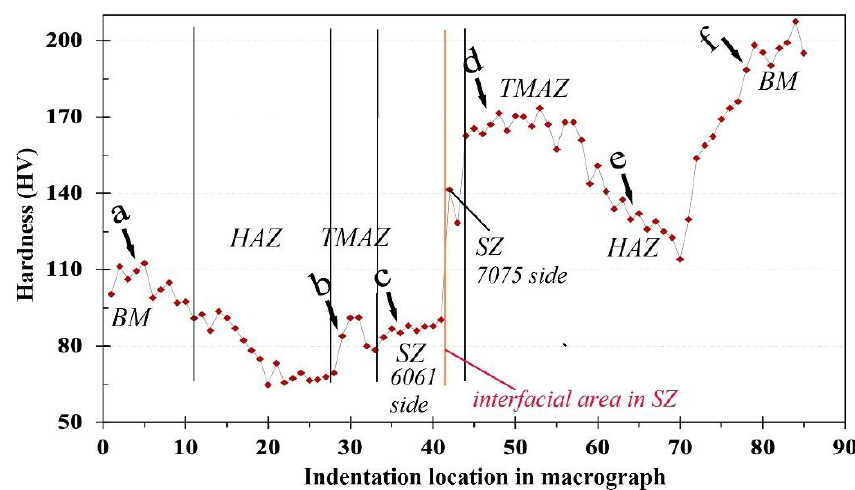
Figure 5. Hardness profile along the line indicated by white line in Figure 2a. ( a – f ) refer to area that their corresponding microstructures are illustrated in Figure 6. The different microstructural zones are also divided in the AA6061 side by black vertical lines.